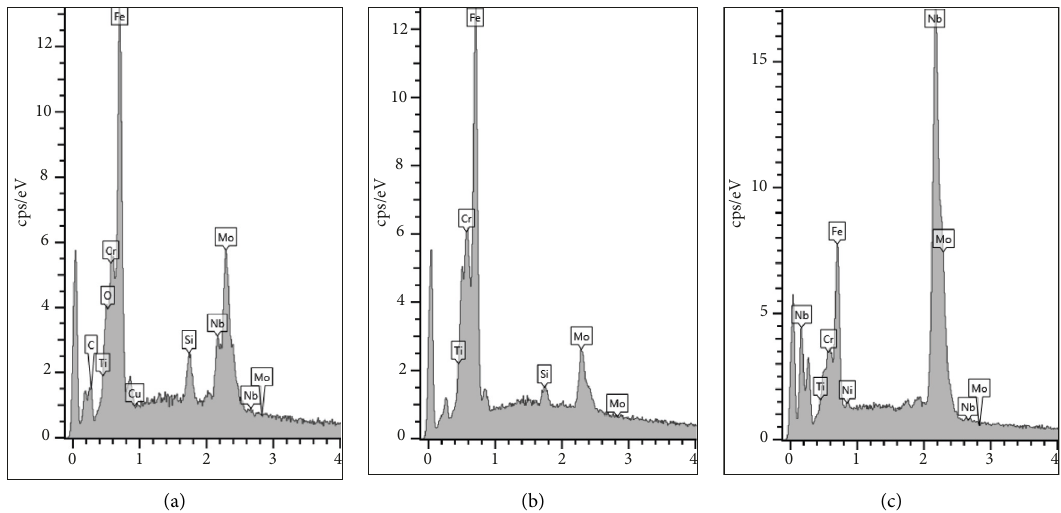
Figure 5: The EDS results of representative precipitated phase for the solution-treated samples after a fire treatment: (a) χ -phase, (b) σ -phase, (c) Laves